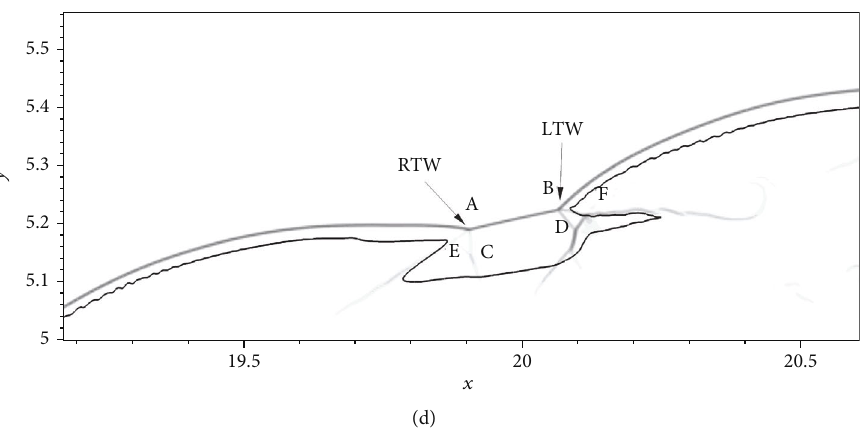
Figure 12: Temporal evolution of the density gradient contour and the RRTW at di ff erent times. (a) t = 15 . (b) t = 15 : 16 . (c) t = 15 : 36 . (d) t = 15 : 52 .